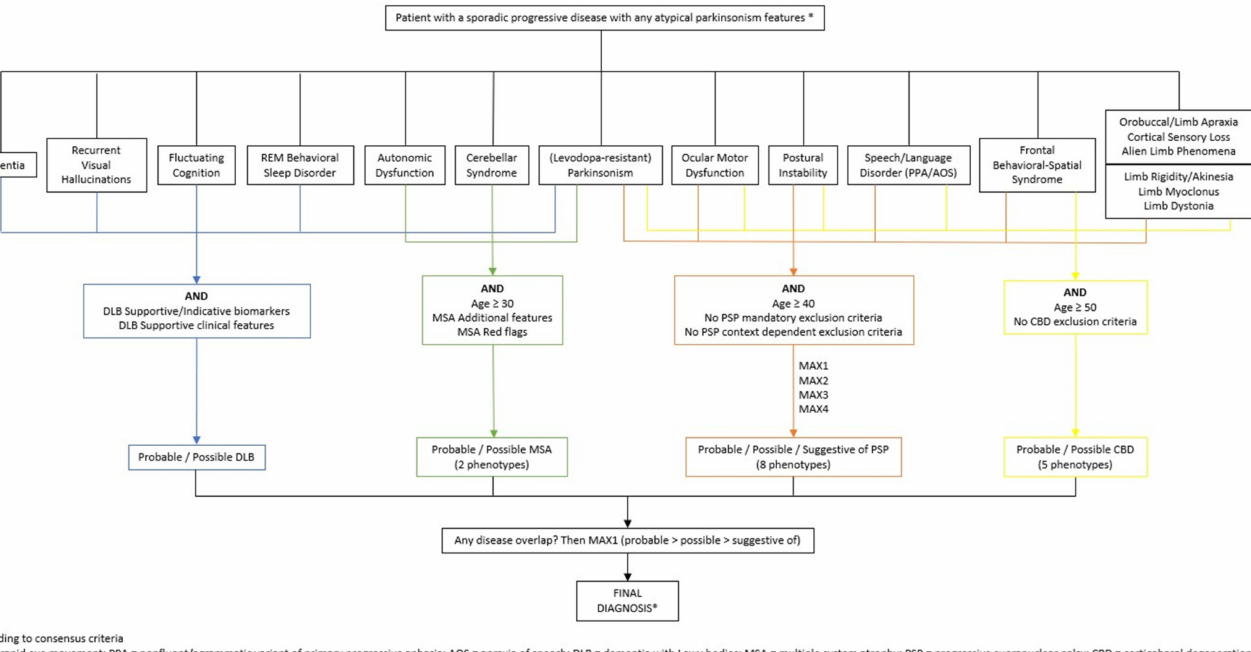
Figure 1. Simplified Decision